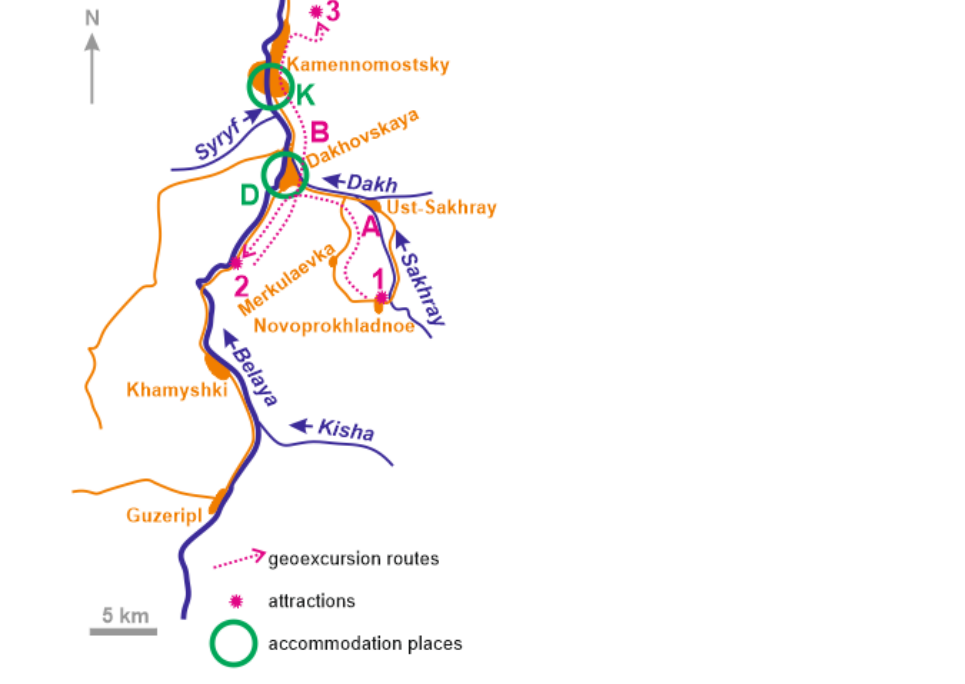
Figure 8. The proposed geoexcursion route connecting the considered geohertage points representing Mesozoic islands of the Caucasian Sea.